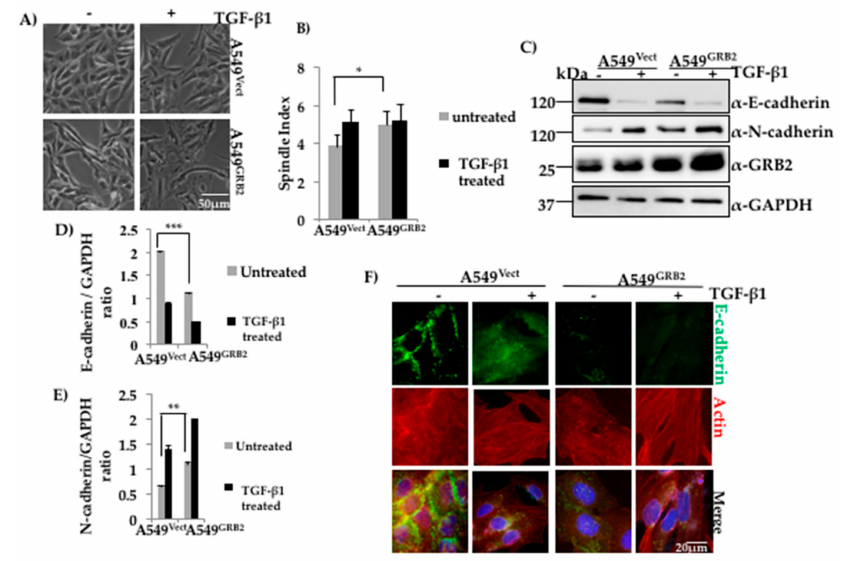
Figure 2. Overexpression of GRB2 enhanced TGF- β 1-induced EMT in A549 cells. ( A ) Control (A549 Vect ) and GRB2 overexpressing (A549 GRB2 ) A549 cells were grown in a 60 mm dish and induced to undergo EMT as described in Figure 1. After 48 h of EMT induction, images were captured using a 10 × objective lens to study morphological changes after TGF- β 1 stimulation; ( B ) Spindle Index, which is the ratio of the maximum length to the maximum width of the cell, was calculated for A549 Vect and A549 GRB2 cells before and after TGF- β 1 stimulation using Image J software. Experiments were carried out in duplicate to calculate significance; ( C ) A549 Vect and A549 GRB2 cells were then scraped, lysed, and the protein extracts were subjected to Western blot analysis using antibodies against E-cadherin, N-cadherin and GRB2. GAPDH was used as the loading control; ( D ) Densitometric analysis of E-cadherin expression level from panel C was carried out using Image J software. (*** p < 0.001); ( E ) Densitometric analysis of N-cadherin expression level from panel C was carried out using Image J software. (*** p < 0.001); ( F ) A549 Vect and A549 GRB2 were seeded on coverslips and EMT was induced with TGF- β 1 as described in Figure 1. After 48 h of induction of EMT, the cells were fixed and immunostained using antibodies against E-cadherin (green) and actin (red). DAPI was used to stain the nucleus. Images were taken under a 40 × oil immersion